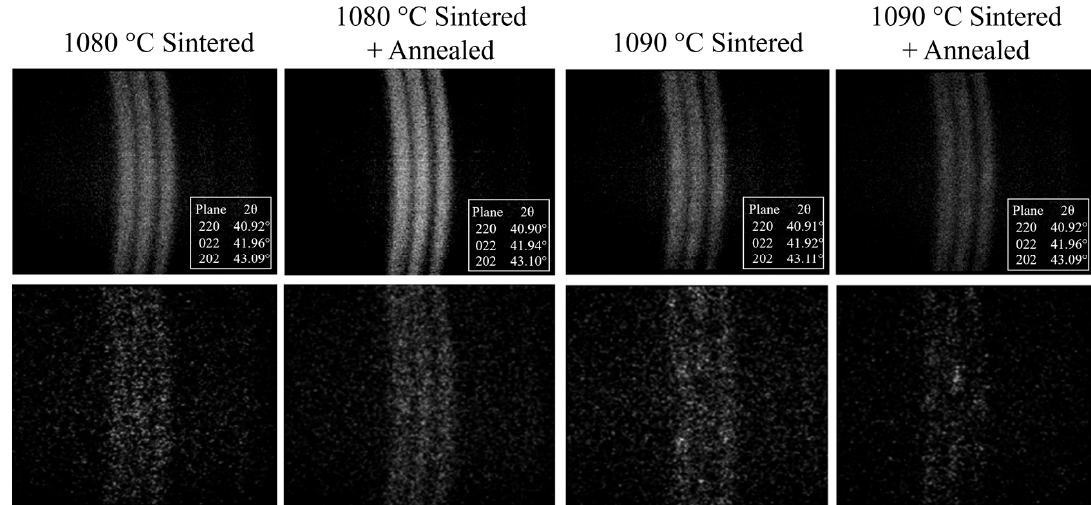
Figure 3. Processed and integrated area detector diffraction images ( top ) and individual example processed diffraction images taken at one Ω step ( bottom ) for each of the four samples. Images are taken of the (220) plane family of 14M Ni–Mn–Ga martensite. Insets of each diffraction image display the location of the integrated diffraction curve for each band. These diffraction angles were used to determine lattice parameters for each sample.